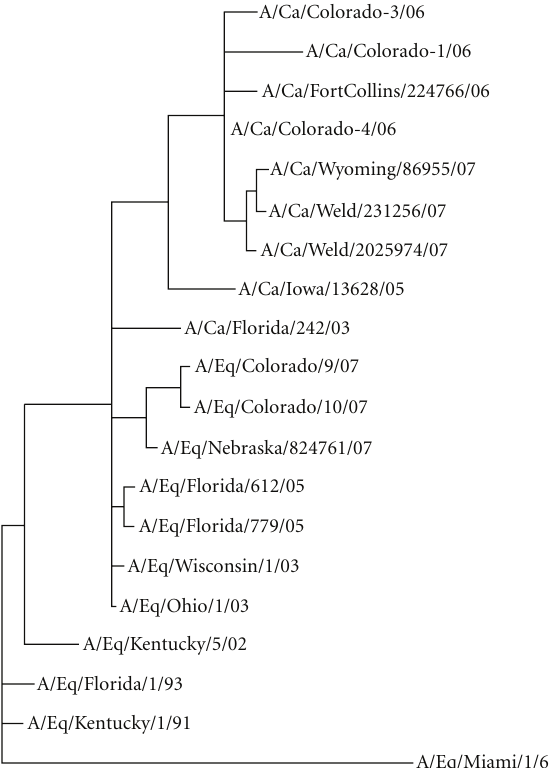
Figure 1: Phylogenetic relationships at the nucleotide level among the hemagglutinin 3 (H3) genes of contemporary canine (including Ca/CO-1, Ca/CO-3, and Ca/CO-4 used in this study) and equine influenza viruses. Scale bar represents a di ff erence at the nucleotide level of 5%.